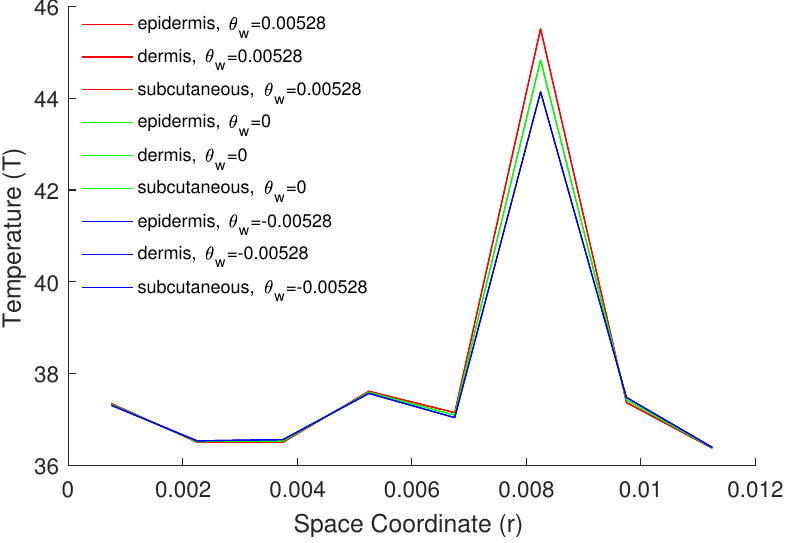
Figure 4. Temperature distributions for different values of θ w in first kind B.C.